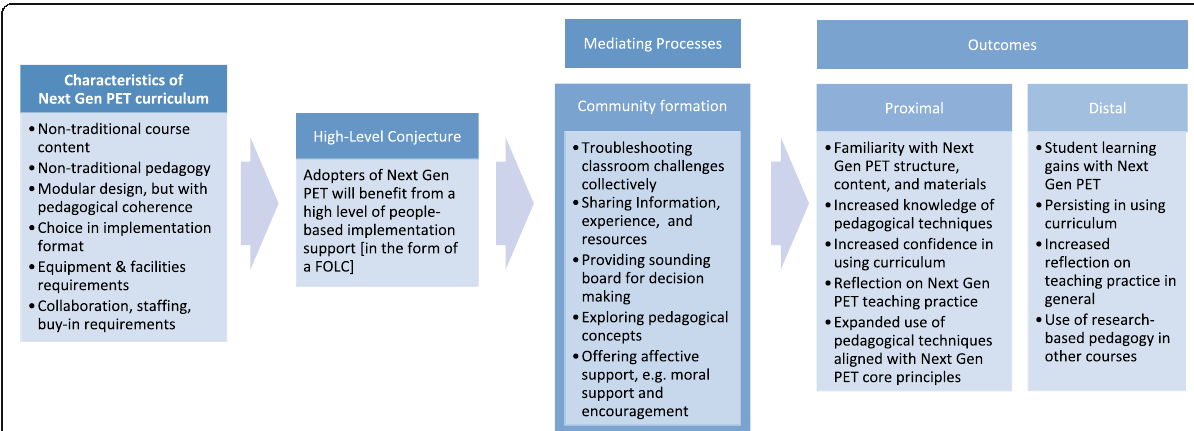
Fig. 1 Conjecture map. Given the characteristics of Next Gen PET, adopters of the curriculum will benefit from extensive, ongoing people-based implementation support. This support is provided by the five mediating processes. The theoretical conjecture, represented by the third arrow in the figure, proposes that if the mediating processes are provided by the FOLC, we expect to see participants reaching the outcomes shown (the goals for FOLC participants). Achievement of these outcomes indicates the FOLC is helping meet the needs of